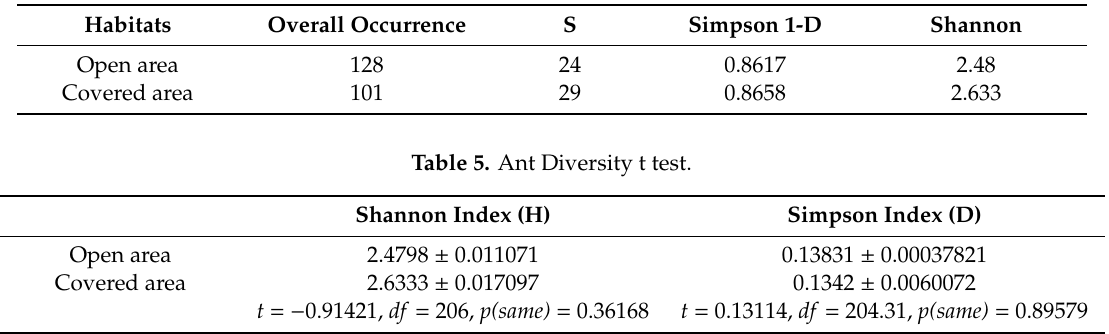
Table 4. Ant diversity index in the two habitats (S = total observed species for each habitat).